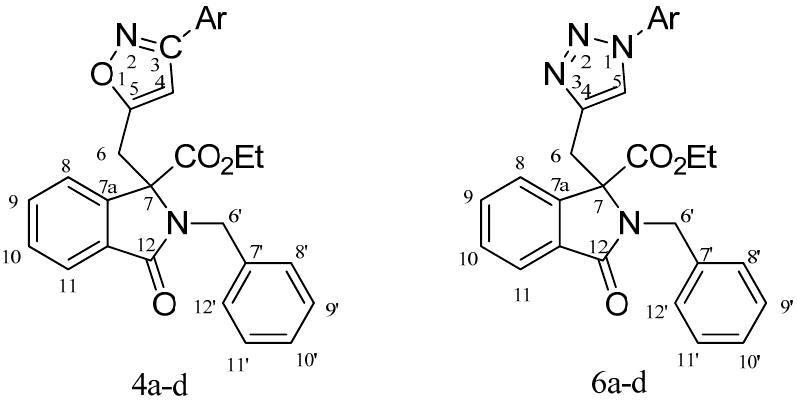
Figure 2. Numbering scheme of the isoxazole 4a – d and 1,4-disubstituted 1,2,3-triazoles 6a – d .